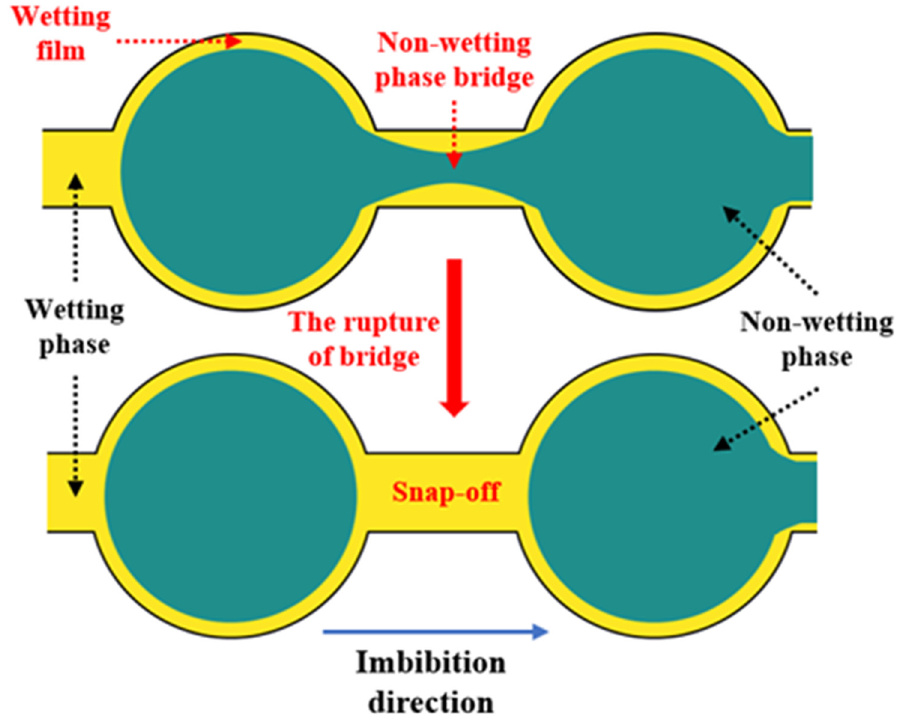
Figure 1. The snap-off in the spontaneous imbibition. (The thickness of the continuous wetting film is greatly exaggerated here.)